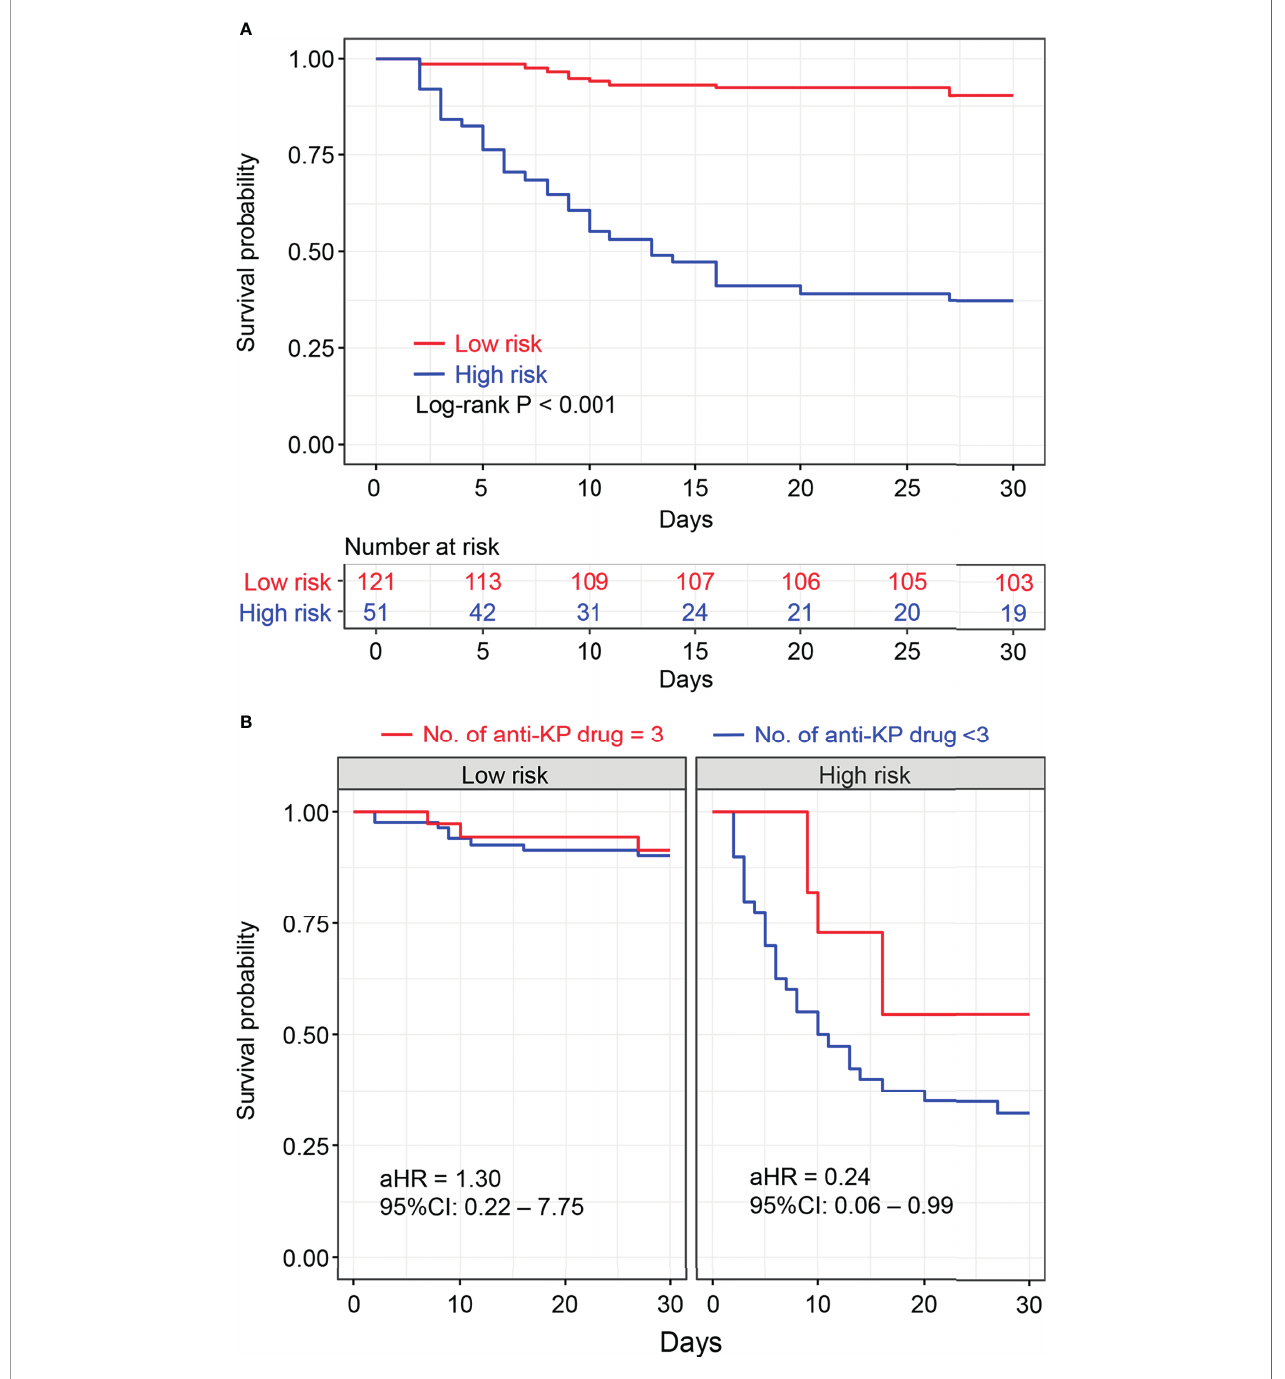
FIGURE 4 | Kaplan – Meier survival plots of risk strati fi cation according to the nomogram total points (A) . Kaplan – Meier survival plots for the number of anti- Klebsiella pneumoniae drugs associated with risk strati fi cation were shown (B) , and adjusted hazard risk ratios (aHR) with 95% con fi dence intervals (CI) were estimated using the Cox regression analysis adjusted for age, sex, comorbidities, clinical status, and site of infection as potential